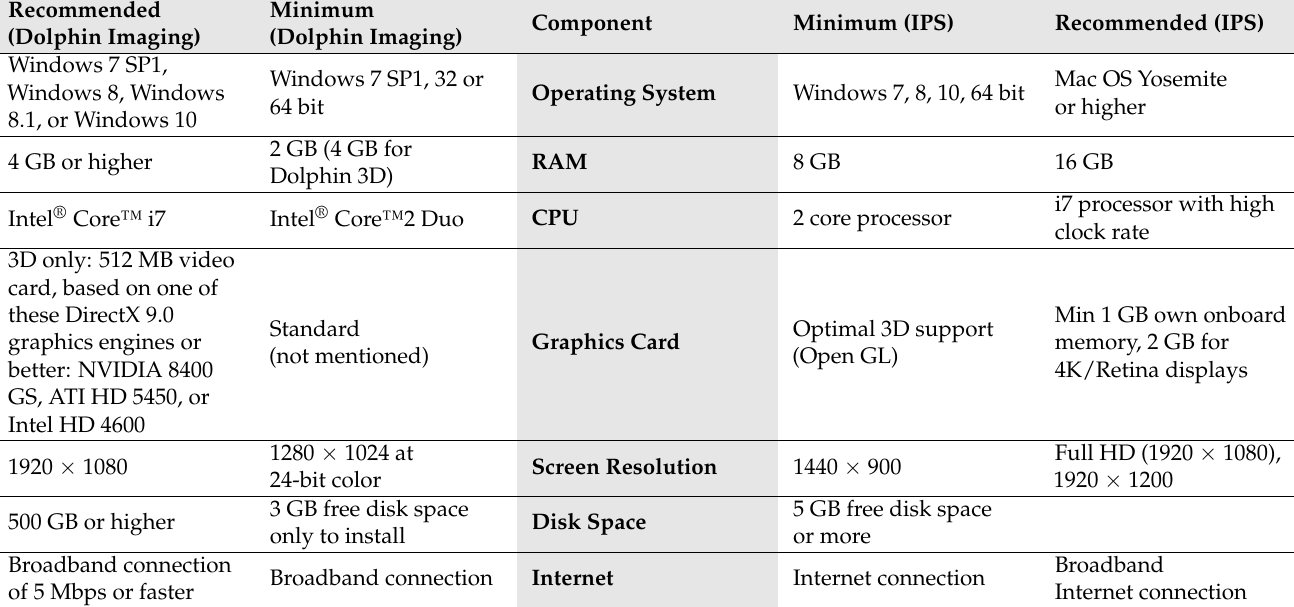
Table 3. Minimal requirement to work with the two